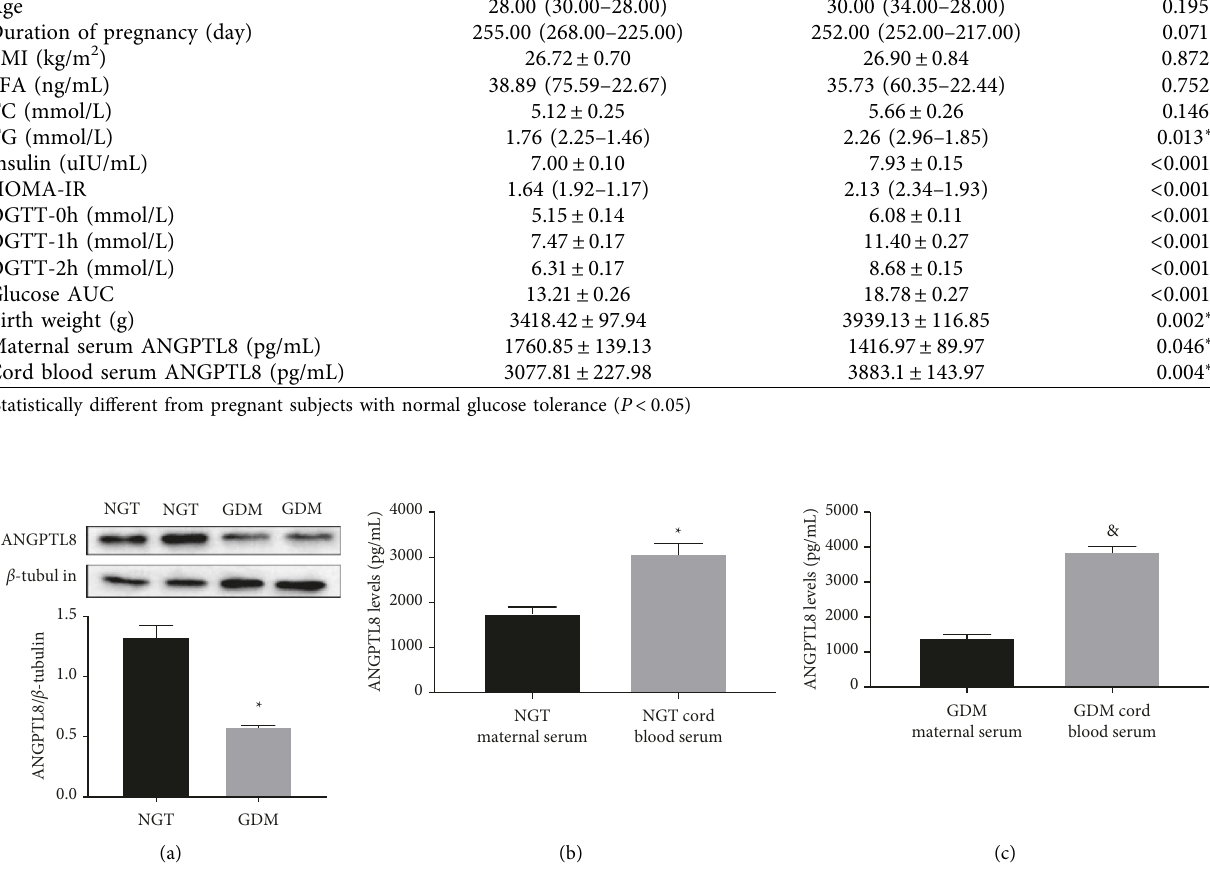
Figure 1: ANGPTL8 levels in maternal serum, cord blood serum and placenta. Maternal serum and cord blood serum samples were used to measure the ANGPTL8 levels in the samples. N � 19 for NGT pregnant women and N � 23 for GDM pregnant women. Placenta samples were assessed with western blotting for the ANGPTL8 expression levels in the samples. Three independent samples were used per group. (a) The protein expression level of ANGPTL8 in placenta. (b) Comparison of maternal serum and cord blood serum ANGPTL8 levels from pregnant subjects with normal glucose tolerance. (c) Comparison of maternal serum and cord blood serum ANGPTL8 levels from pregnant subjects with diabetes mellitus. ∗ : statistically different from pregnant subjects with normal glucose tolerance ( P < 0 . 05) &: statistically different from pregnant subjects with diabetes mellitus ( P < 0 . 05).